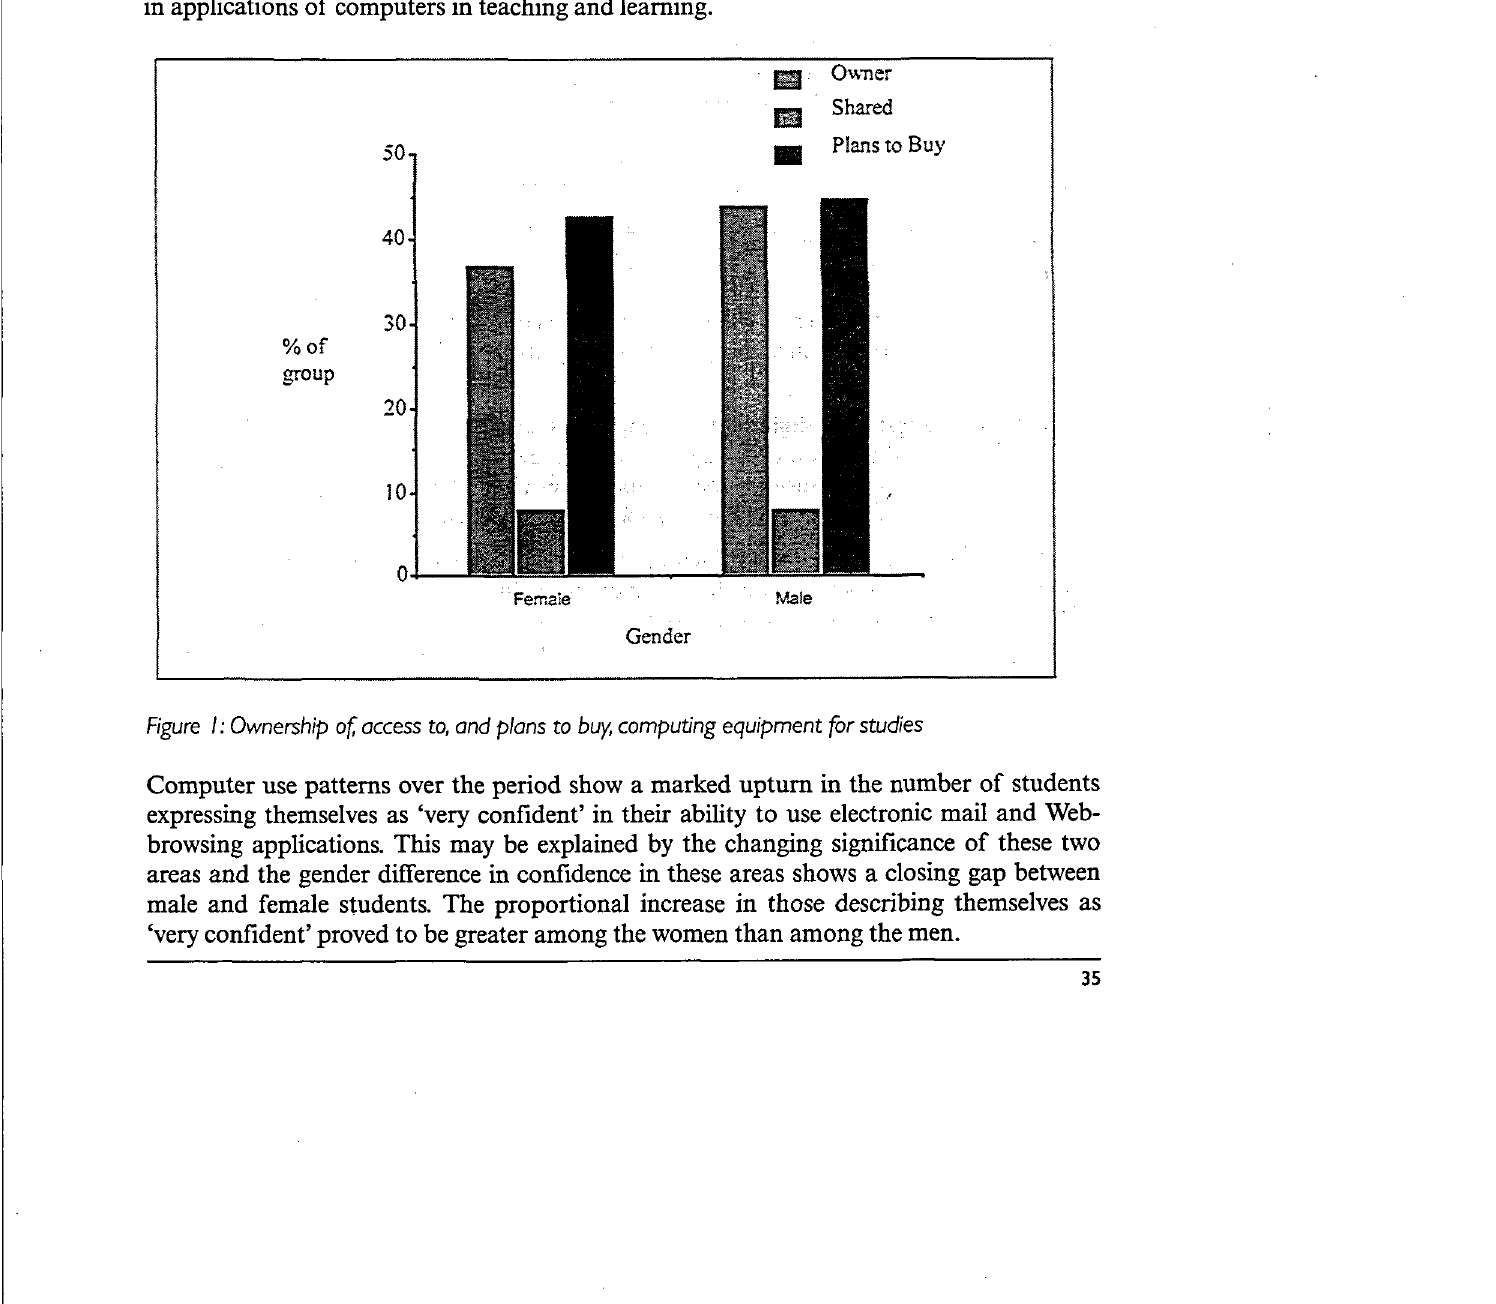
Figure I: Ownership of, access to, and plans to buy, computing equipment for studies Computer use patterns over the period show a marked upturn in the number of students expressing themselves as 'very confident' in their ability to use electronic mail and Web- browsing applications. This may be explained by the changing significance of these two areas and the gender difference in confidence in these areas shows a closing gap between male and female students. The proportional increase in those describing themselves as 'very confident' proved to be greater among the women than among the